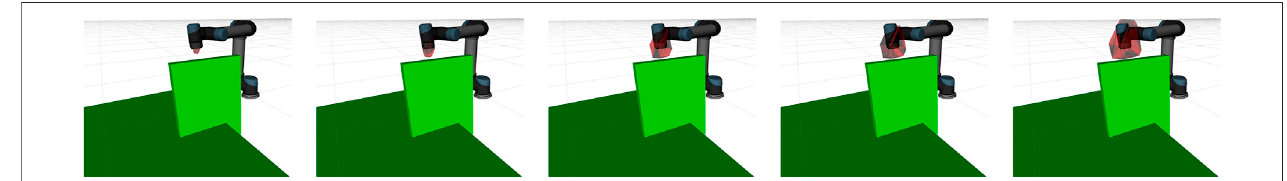
FIGURE 2 | Visualization ofthe shrinking constrained motion polytope, withoriginatrobot toolframe.Fromlefttoright,the linearizationlimit isselectedas ϵ lin (cid:1) 0.038,